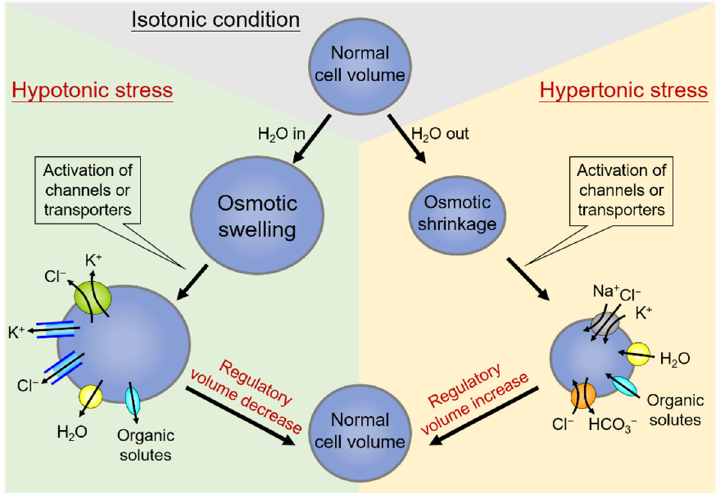
Figure 1. Regulation and homeostasis of cell volume: regulatory volume decrease (RVD) and regu- latory volume increase (RVI). Under hypotonic stress conditions of cell swelling ( left side ), the cell activates the regulatory volume decrease (RVD). In this condition, the volume-regulatory accumulation and loss of electrolytes are mediated by the activity of membrane channels or transporters responsible for the loss of K + and Cl − , and organic solutes along with water in response to cell swelling. On the contrary, cell volume shrinks due to water extrusion under hypertonic stress ( right side ), and a counter-response of regulatory volume increase (RVI) occurs to restore normal cell volume. Shrunken cells can thereby increase their volume towards the original levels by upregulating the net influx of cell osmolytes, including Na + , Cl − , and often K + , and concurrent uptake of